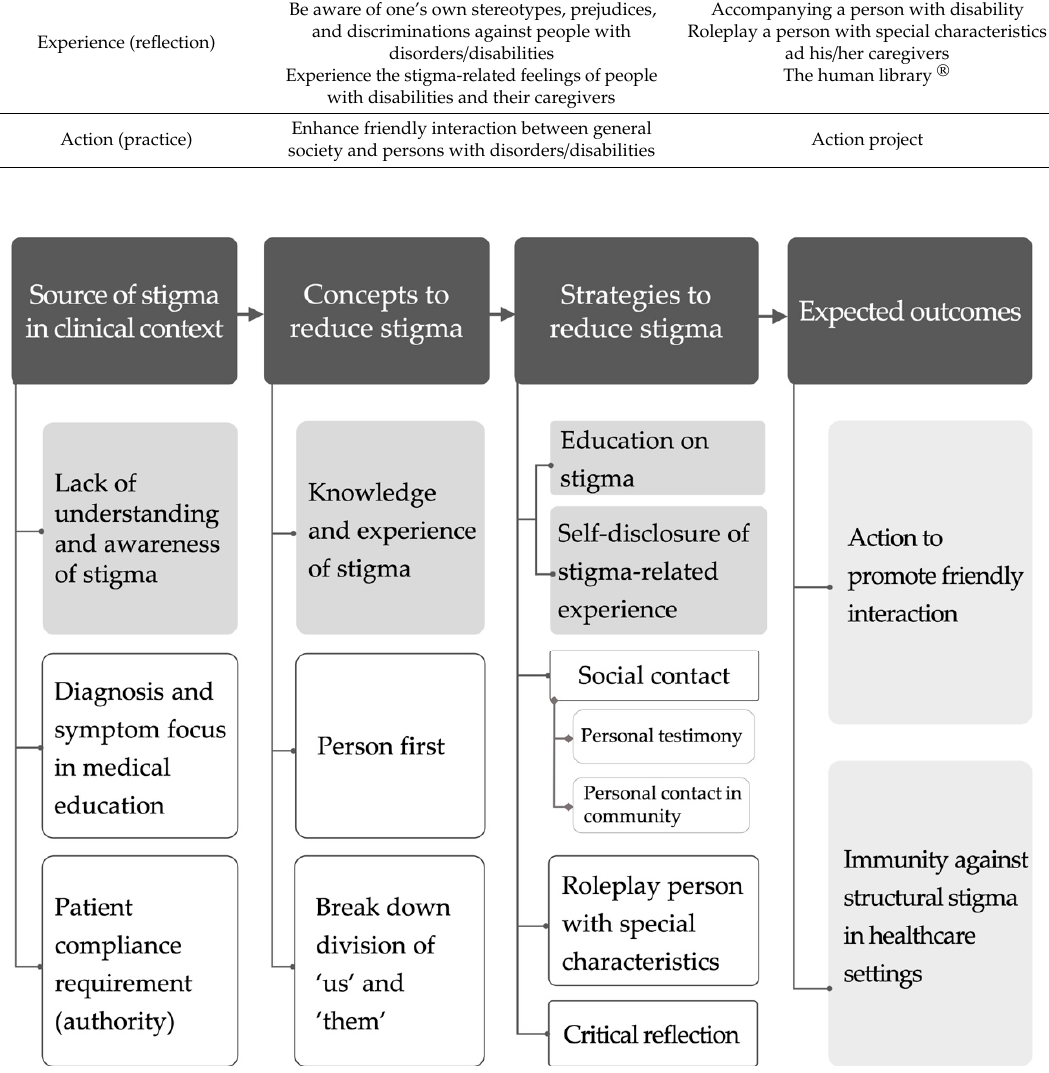
Table 1. Course framework. Stage